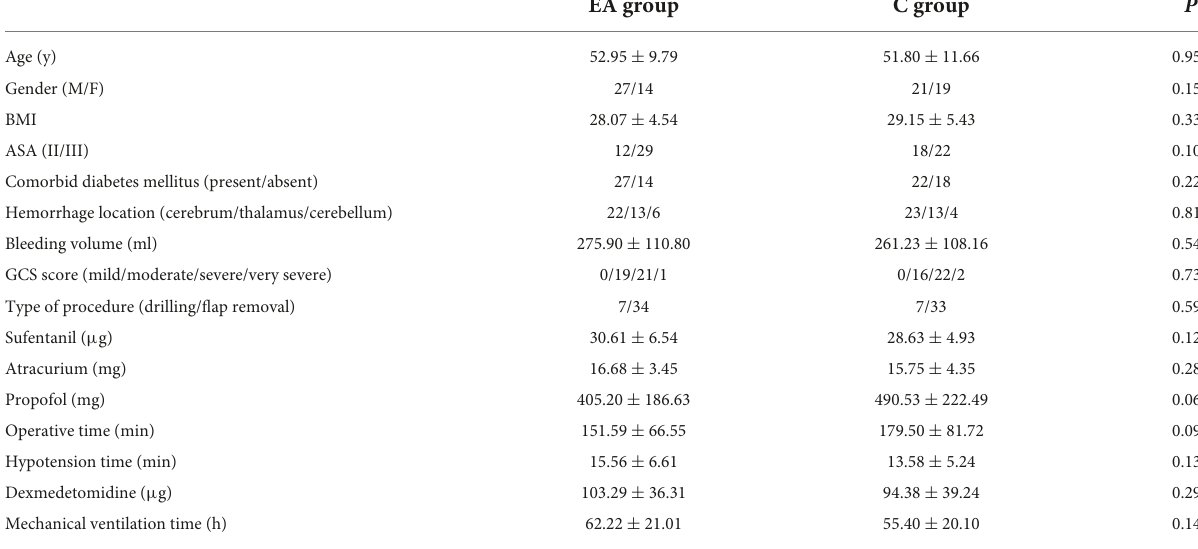
TABLE 1 Comparison of baseline data between the two groups (EA group n = 41, C group n = 40, n % or X ± SD).